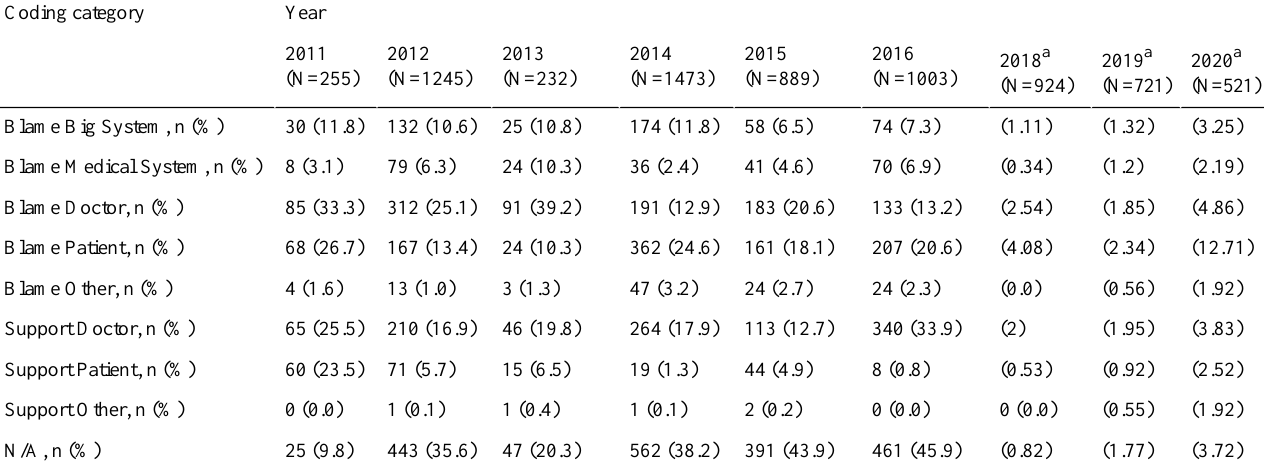
Table 4. Number and percentage of coding